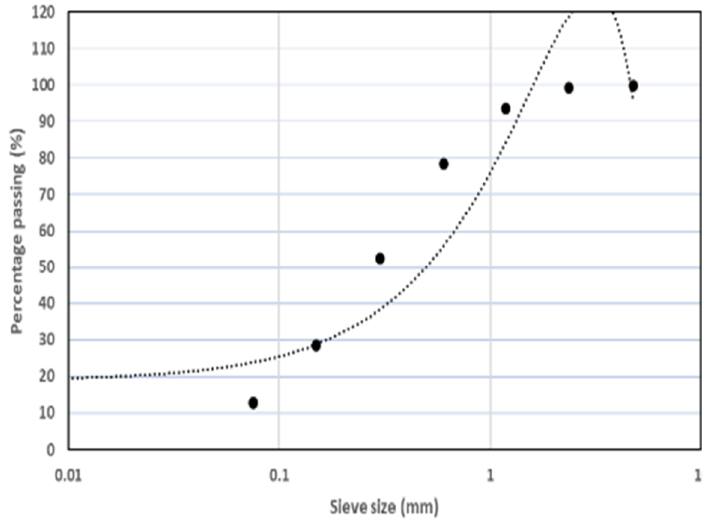
Figure 1. Particle size distribution of quarry dust. Table 1. Physical properties of the materials.